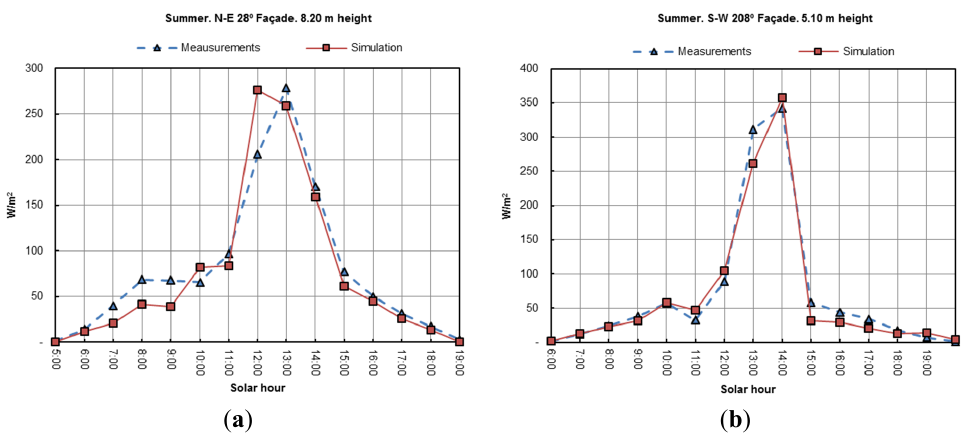
Figure 7. 24 h comparison between cell measurements and simulations, winter in Cadiz. ( a ) N-E 28º Façade. ( b ) S-W 208º Façade.